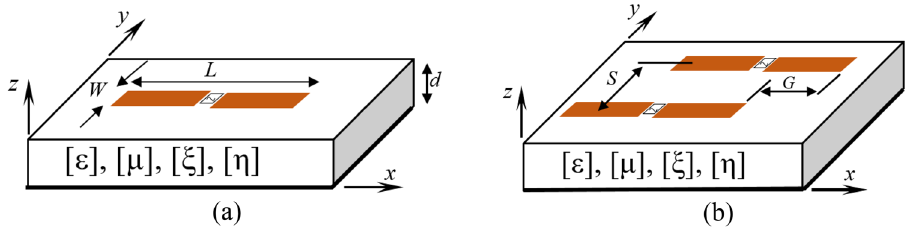
Figure 4. Geometries of ( a ): Printed dipole and ( b ): Two-element dipole